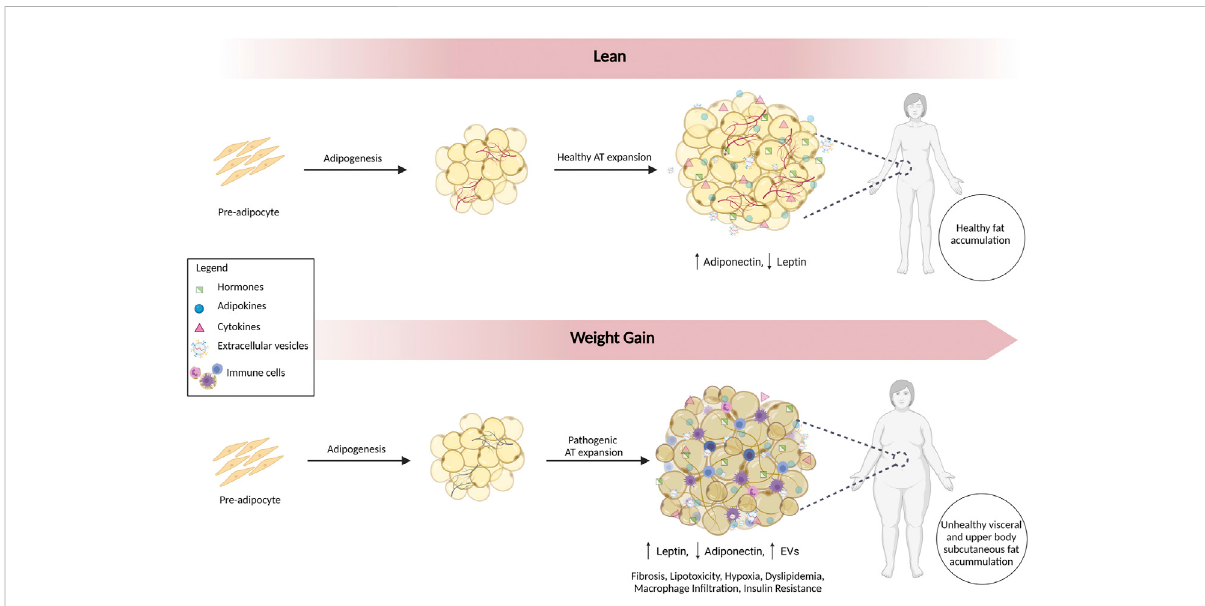
FIGURE 1 Alterations in Adipose Tissue in Adiposopathy. Adipogenesis involves the differentiation of adipocytes from pre-adipocytes. In lean individuals, healthy accumulation of subcutaneous fat predominates. With adiposopathy, WAT becomes dysfunctional, and expansion is accompanied by in fl ammation, fi brosis, lipotoxicity, hypoxia, dyslipidemia, macrophage in fi ltration, insulin resistance, dysregulated secretion of adipokines, and EVs. Fat accumulation occurs in metabolically unhealthy visceral and upper body subcutaneous